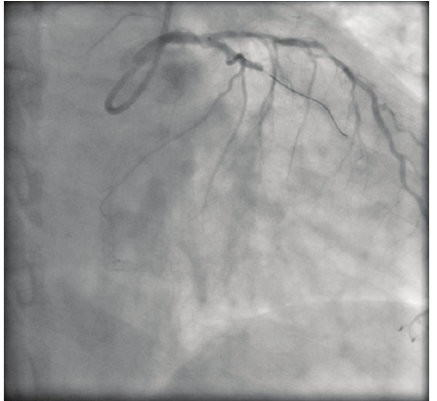
Figure 3: Crossing the LCX.